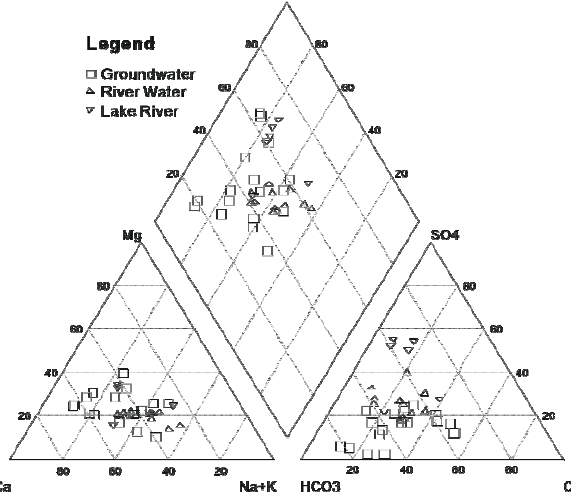
Fig. 7. Piper diagram of major ion chemistry for groundwater, river water and lake water in the study